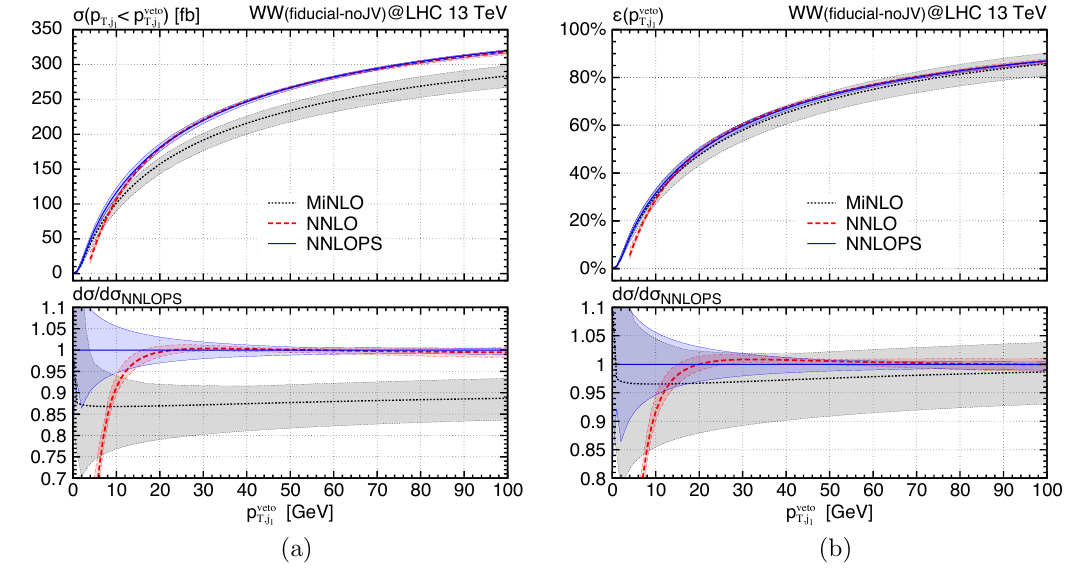
Figure 6 . Comparison of MiNLO (black, dotted), NNLO (red, dashed) and NNLOPS (blue, solid) predictions in the (cid:12)ducial phase space as a function of p veto jet-veto